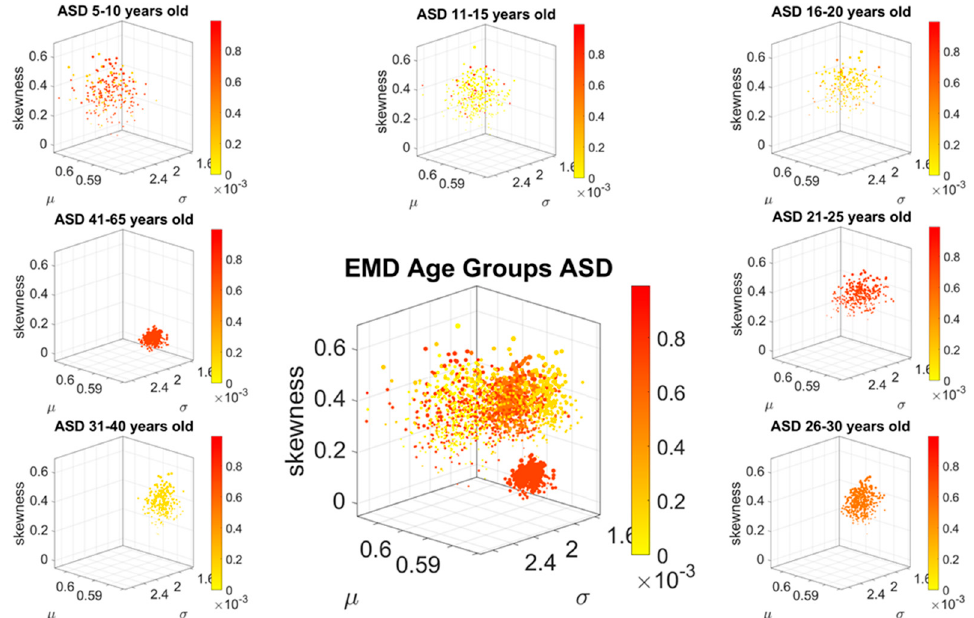
Figure 6. Stratification of ASD by EMD capturing the pairwise differences in probability distributions empirically estimated from the MMS representing the involuntary fluctuations in the linear displacements of the head. Notice that each scatter is different in spread and range of EMD. Earlier years up to 20 are more heterogeneous than later years in that they have a broader spread in the Gamma moment parameter space that is accompanied by heterogeneous distances in probability space. This trend changes with aging. After 20 years of age, the scatter spread decreases and the EMD maximally separating each individual within the group from the rest of the age group becomes more homogeneous. Each person’s signature is close in probability space. Their fluctuations in involuntary motions become statistically closer. Then, by 40 years of age they are maximally close in probability space and their scatter’s spread tends to shrink. After 40 years of age, there is a fundamental departure of the ASD signatures from the rest of the cohort. Compare these scatters to those in Figure 2 representing the normative data, to best appreciate that aging with ASD is different from typical aging. The trajectory evolution of the stochastic signatures in the probability landscape serves as a natural classifier of autism’s involuntary motions. 3.2. Differences in the Scatters Representing Each Age Group To ascertain the shifting differences in the spread of the scatter of points representing the empirically estimated Gamma moments of the MMS derived from the involuntary linear speed of each participant, we obtained the Delaunay triangulation of the scatter. For each unique triangle found by the Delaunay algorithm, we computed the area and studied the patterns of variability of the triangles’ areas across each age group within each cohort. Figure 7 shows that for each age group, the ASD scatter had a fundamentally different spread signature than the neurotypical scatter. This is shown through the empirically estimated PDF representing the signatures derived from the Delaunay triangulation that we obtained from each group’s scatter. The square symbol localizing the shape and scale of the PDF on the Gamma parameter plane is for ASD participants. The circle symbol is for the age-matched TD participants. Further, the figure reflects the shifting nature of the scatter spread variability. In each age group, the empirically estimated Gamma PDF characterizing the spread of the ASD scatter shifted with respect to the age-matched controls, as shown by the PDF insets of each corresponding Gamma parameter plane. The color range represents the average Earth Mover’s Distance (normalized between 0 and 1) between the PDFs representing the variability of the triangles’ areas in the Delaunay triangulation of the scatter. For example, in the 41–65 group, the yellow circle representing the controls has a triangulation with lower scatter variability than the red square representing the ASD participants of